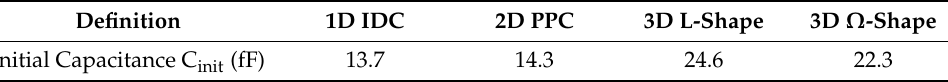
Table 1. Initial capacitances (C init ) of the 1D and 2D/3D designs.